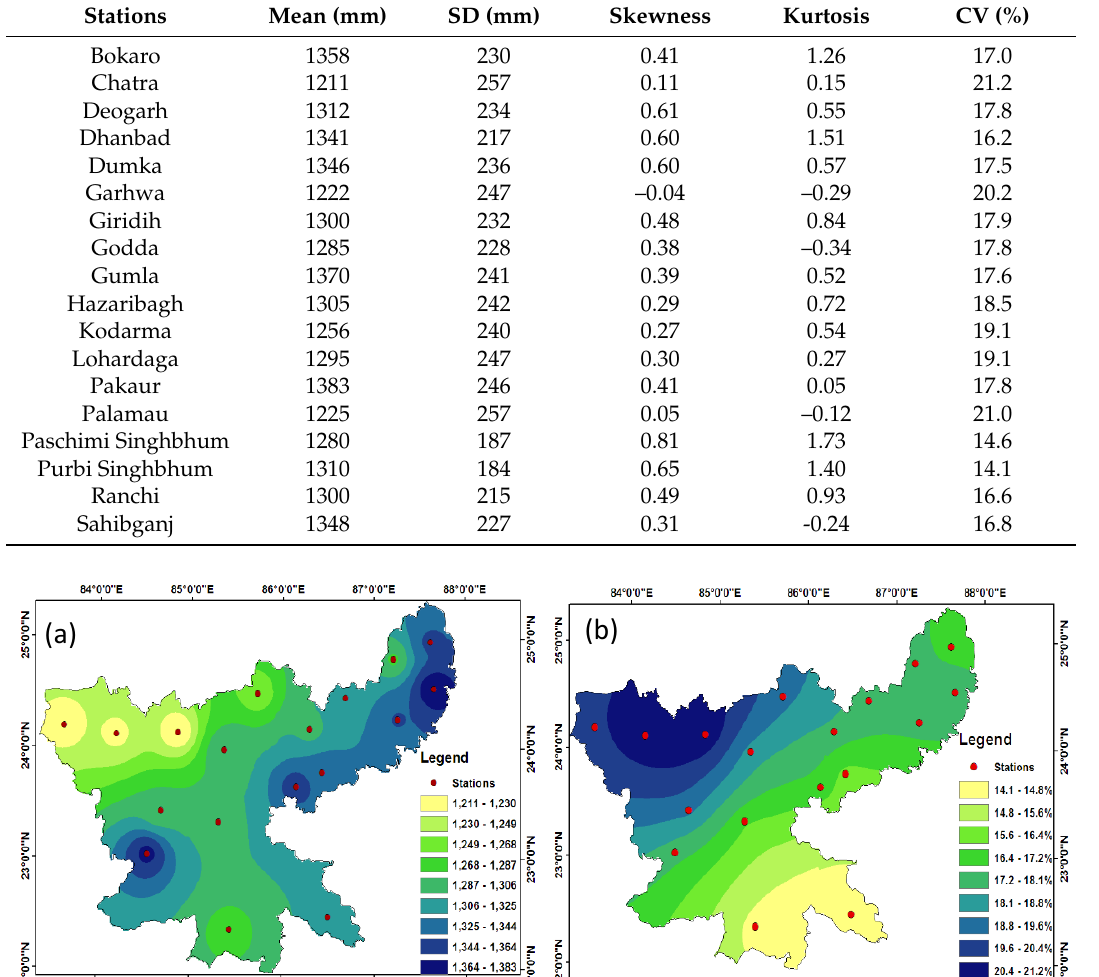
Figure 2. The spatial distribution of ( a ) rainfall and ( b ) Coefficient of variation in annual rainfall over the period of 1901–2002.